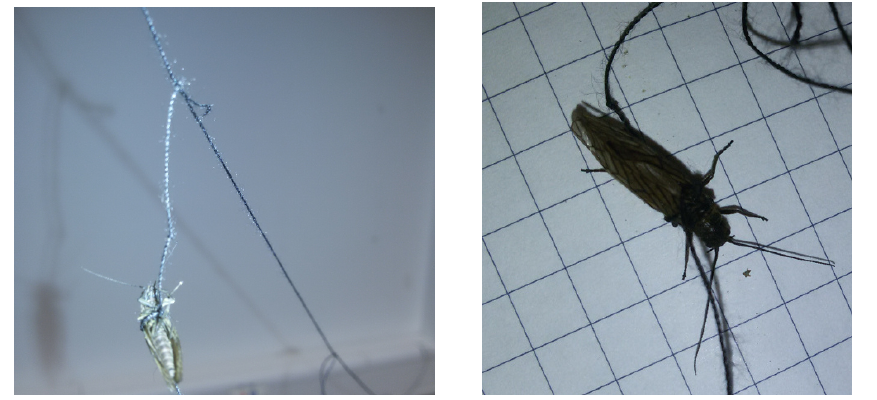
Figure A6. An experiment with Sialis lutaria .